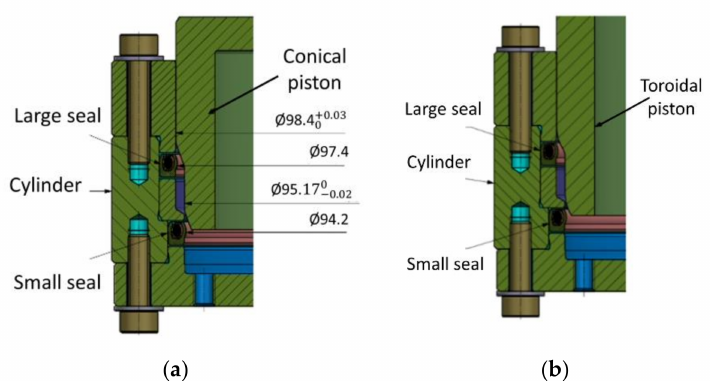
Figure 12. The device with seals mounted; ( a ) the starting position of the old piston in the cylinder; ( b ) the starting position of the new piston in the